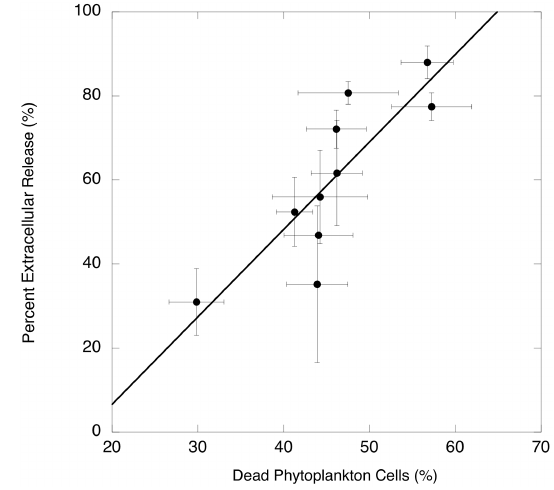
Figure 5. The relationship between the percentage of dead phy- toplankton cells (%DC) and the percentage of phytoplankton ex- tracellular carbon release (PER), averaged by stations across the study. The full line represents the fitted regression equation: PER = − 35 . 03 + 2 . 08 ( ± 0 . 49) phytoplankton %DC ( R 2 = 0 . 69, P = 0 . 0029, N =